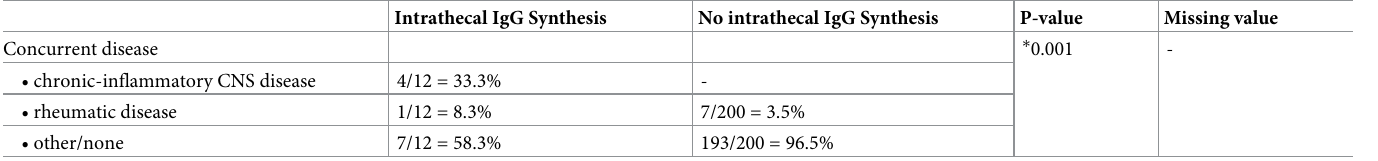
p-value < 0,05 adjusted to Bonferroni correction.